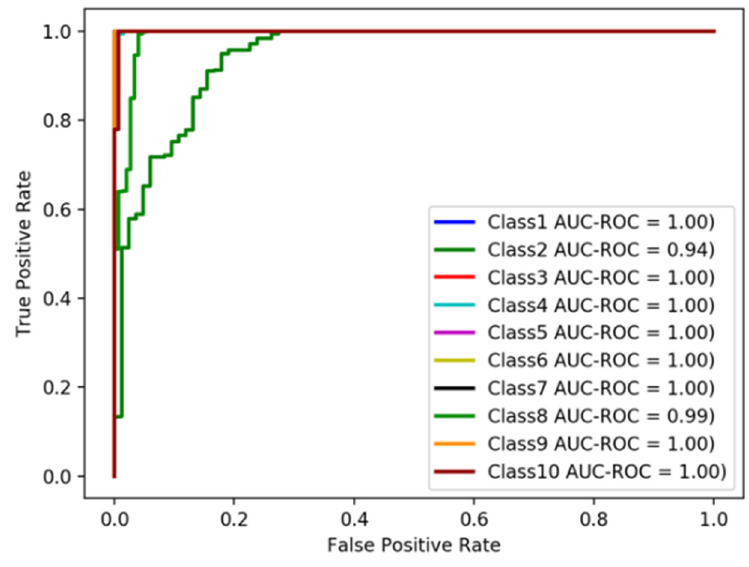
Figure 6. ROC curve and AUC-ROC for 10 classes of data in DAGM dataset. Table 4. True negative rate (TNR) and true positive rate (TPR) performance comparison.